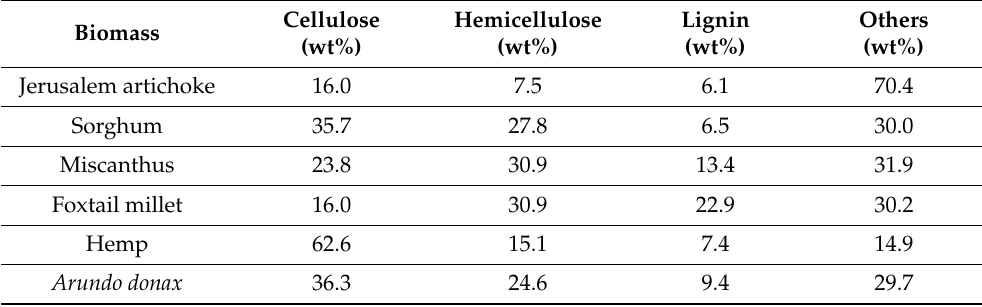
Table 8. Average compositions of the lignocellulosic biomasses employed in the present work. Cellulose Biomass